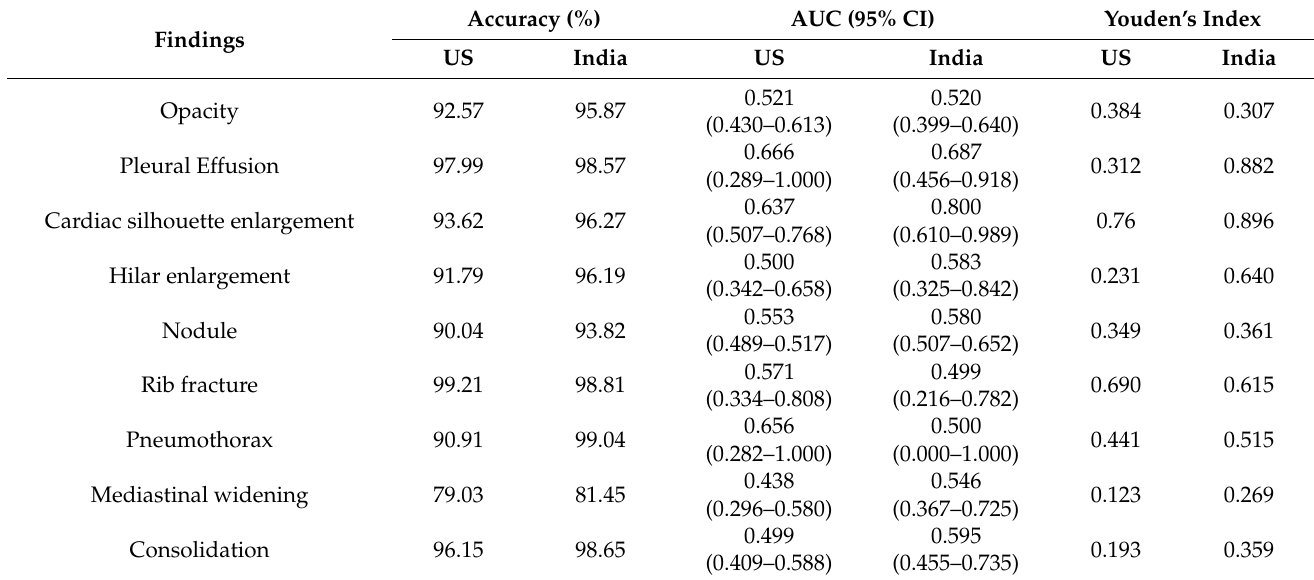
Table 4. Accuracy and area under the curve (AUC) of the AI algorithm based on Youden’s-Index- based thresholds for different findings on CXRs. The numbers within the parentheses represent 95% confidence intervals.